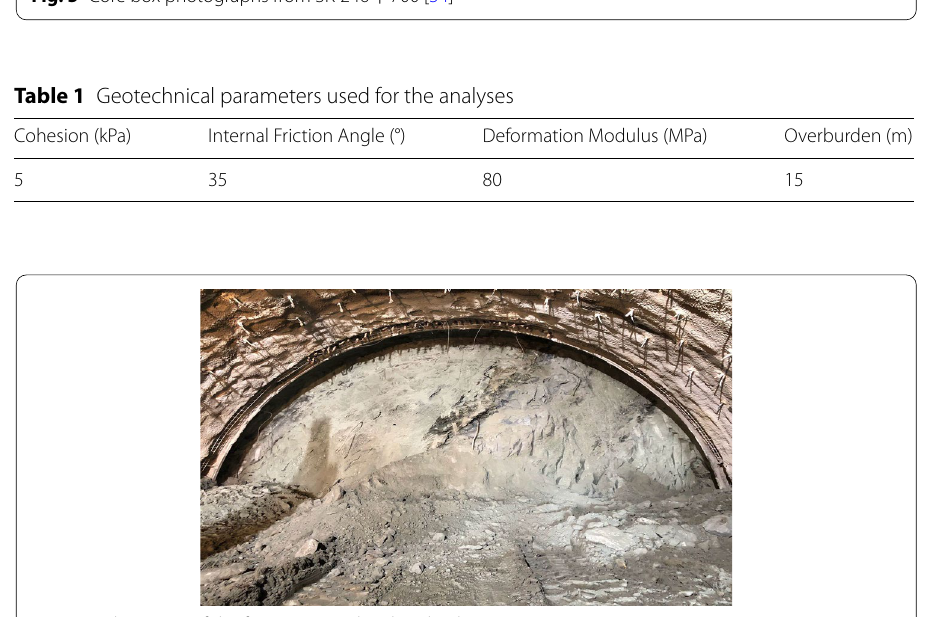
Fig. 5 Core box photographs from SK-246